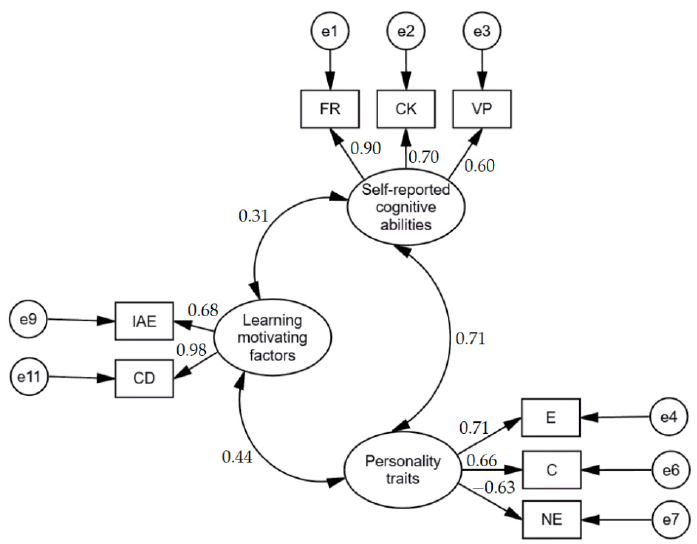
Figure 1. Standardized results of model on associations between learning motivating factors, self- reported cognitive abilities, and personality traits in group of computer programming e-learners. IAE: individual attitude and expectation; CD: clear direction; E: extraversion; C: conscientiousness; NE: negative emotionality; FR: fluid reasoning; CK: comprehension-knowledge; VP: visual processing.